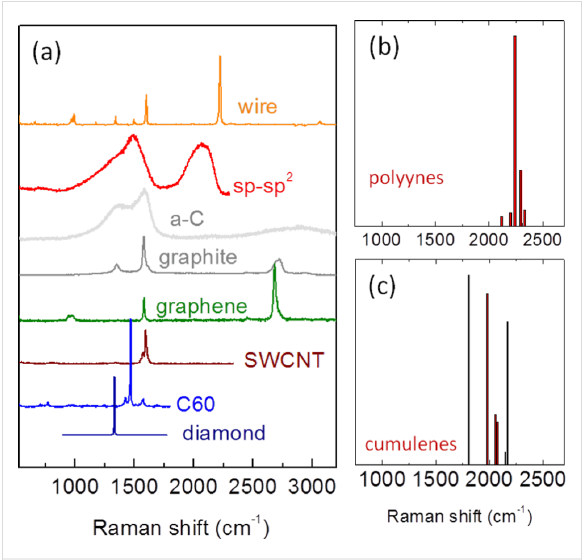
Figure 3: (a) Experimental Raman spectra of carbon solids and nano- structures. (b,c) DFT-computed Raman peaks for finite polyynes and cumulenes of different lengths. Figure adapted with permission from [40], copyright 2010 John Wiley &